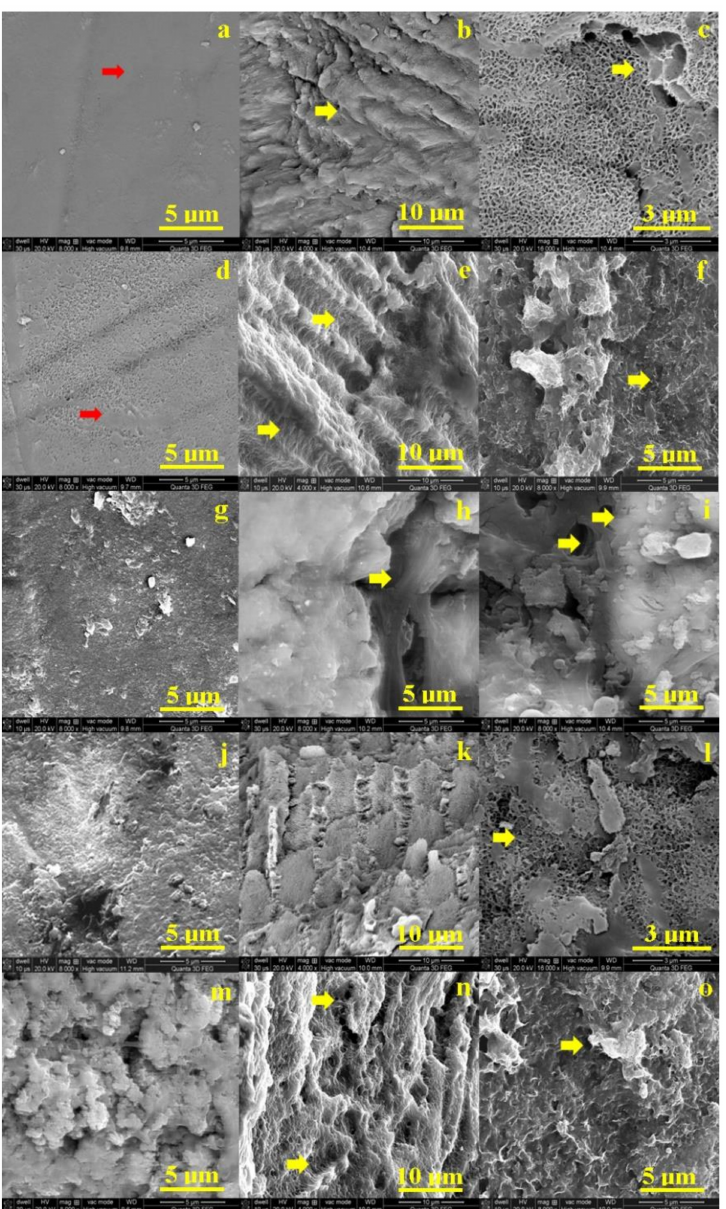
Figure 2. Scanning electron micrograph of: enamel—no exposure ( a ), exposed for 6 h ( d ), 12 h ( g ), 48 h ( j ) and 8 days ( m ); interface—no exposure ( b ), exposed for 6 h ( e ), 12 h ( h ), 48 h ( k ) and 8 days ( n ); and dentine slab—no exposure ( c ), exposed for 6 h ( f ), 12 h ( i ), 48 h ( l ) and 8 days ( o